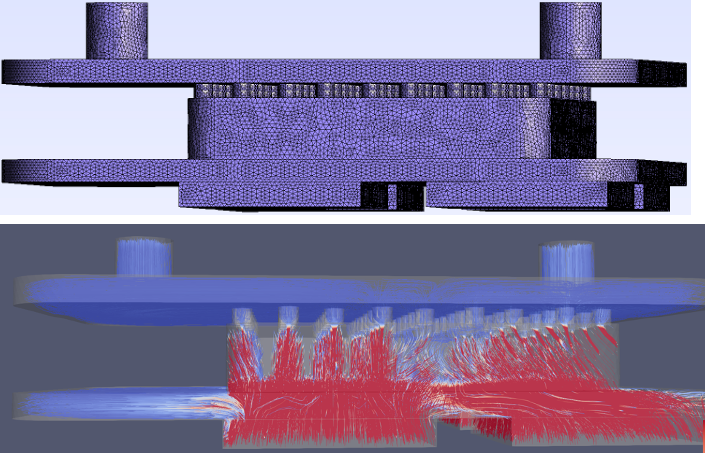
Figure 12. Computational domain and velocity streamlines for the case with two outlets. The maximum velocity is between 3.4